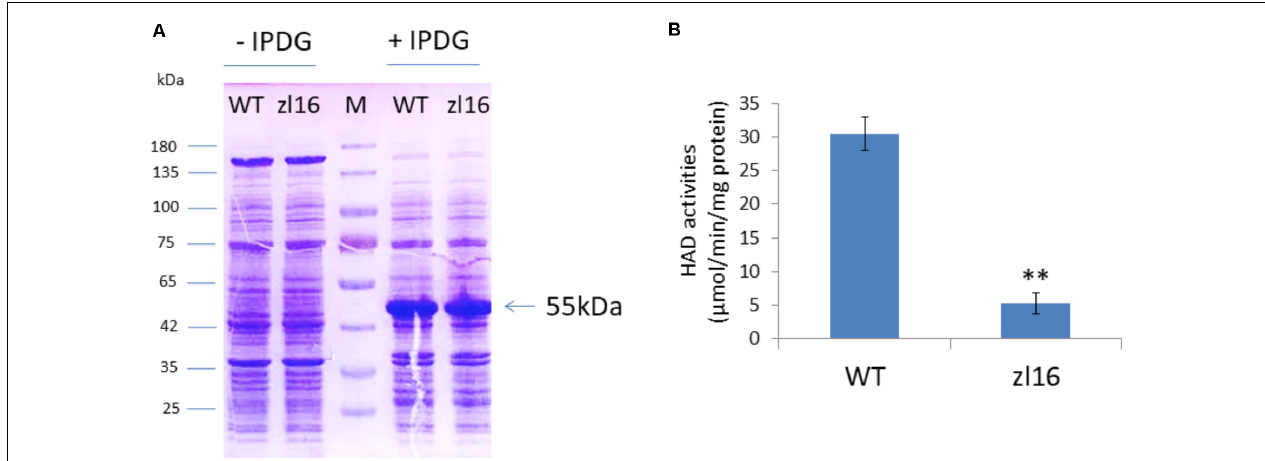
FIGURE 7 | Heterologous expression of recombinant ZL16 proteins in E. coli. (A) Expression of wild-type (WT) and zl16 recombinant proteins in E. coli . –/+ denote before and after adding 1 mM isopropyl-beta- D -thiogalactopyranoside (IPTG) for protein induction. M means molecular weight marker. Arrow indicates the target protein from ZL16 or zl16 (29 kDa) fusing with glutathione S-transferase (26 kDa). (B) Comparison of β -hydroxyacyl-ACP dehydratase (HAD) enzyme activities between the wild type (WT) and zl16 after purification of the recombinant proteins. Data are means ± SD of six replicates. ∗∗ P < 0.01.